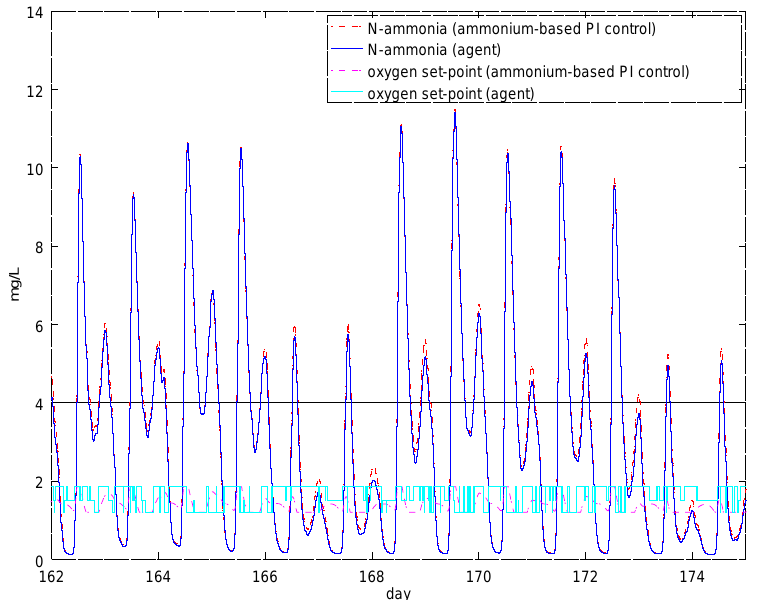
Figure 13. Ammonia-based PI control vs. the RL agent’s behavior throughout the first year: days in the middle. The ammonia set-point in this experiment is fixed to 3 mg/L and a range of DO set-points from 1.2 mg/L to 1.85 mg/L